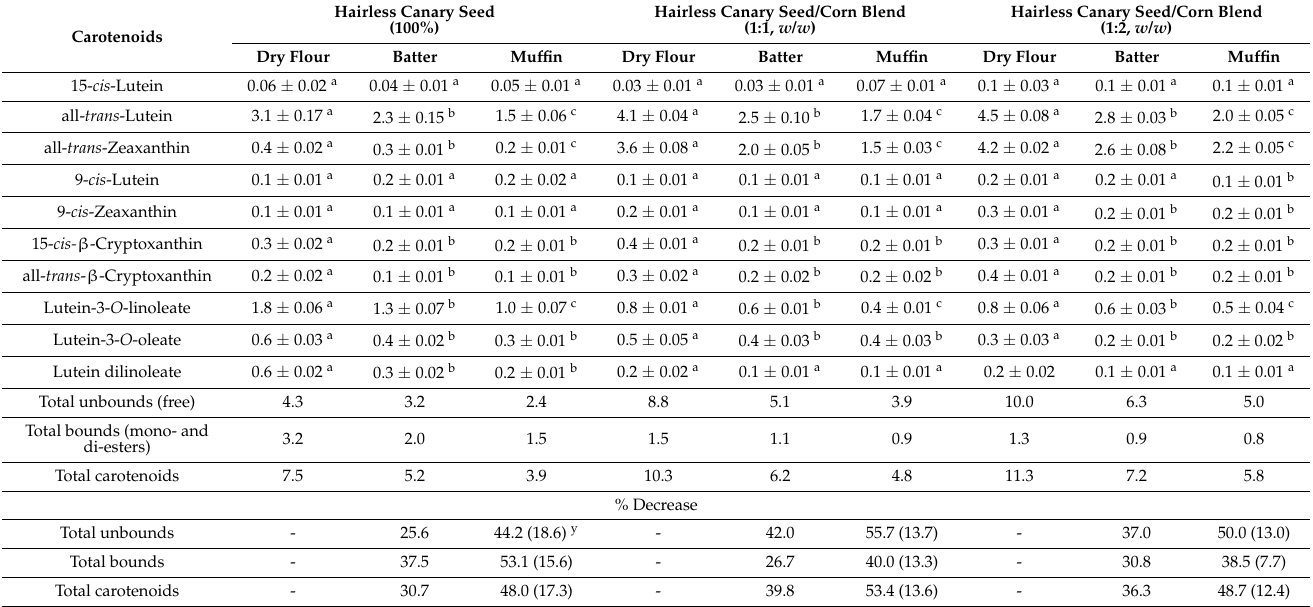
Table 2. Content of major carotenoids in muffin formulations and products ( µ g/g) and the impact of baking process on carotenoids (% decrease) x